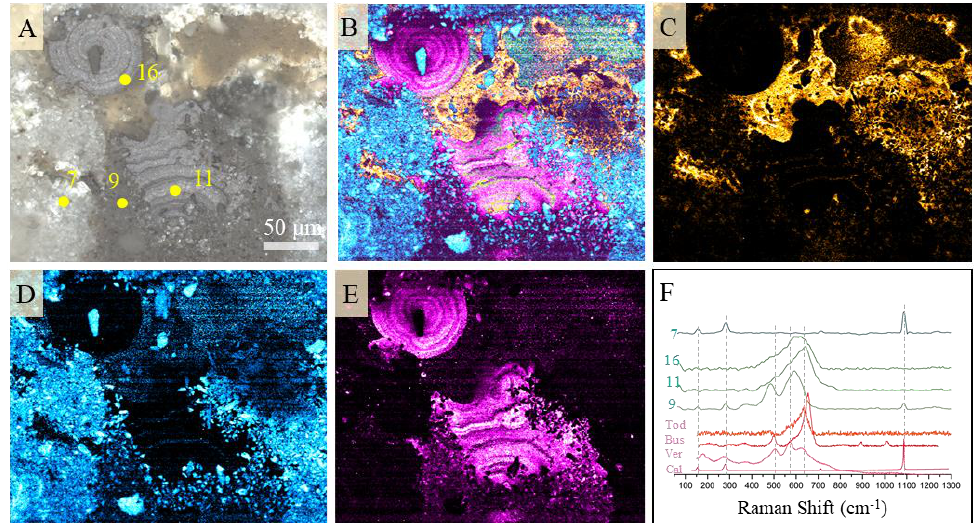
Figure 7. Raman-based probe of mineralogy distribution showing two micro-nodules with sub-spherical shape and laminated shape. ( A ) Reflected light image of the studied area. Numbers indicate the points where Raman spectra shown in ( F ) were acquired. ( B ) Raman mapping distribution of di ff erent minerals (components) in the same view of ( A ). The signature of resin ( C ), mapping of calcite ( D ) and manganic minerals ( E ). ( F ) Number labels of each Raman spectrum indicate the selected points in ( A ). Reference spectra of di ff erent manganic minerals (todorokite, buserite and vernadite) and calcite from the RRUFF database were used for comparation.